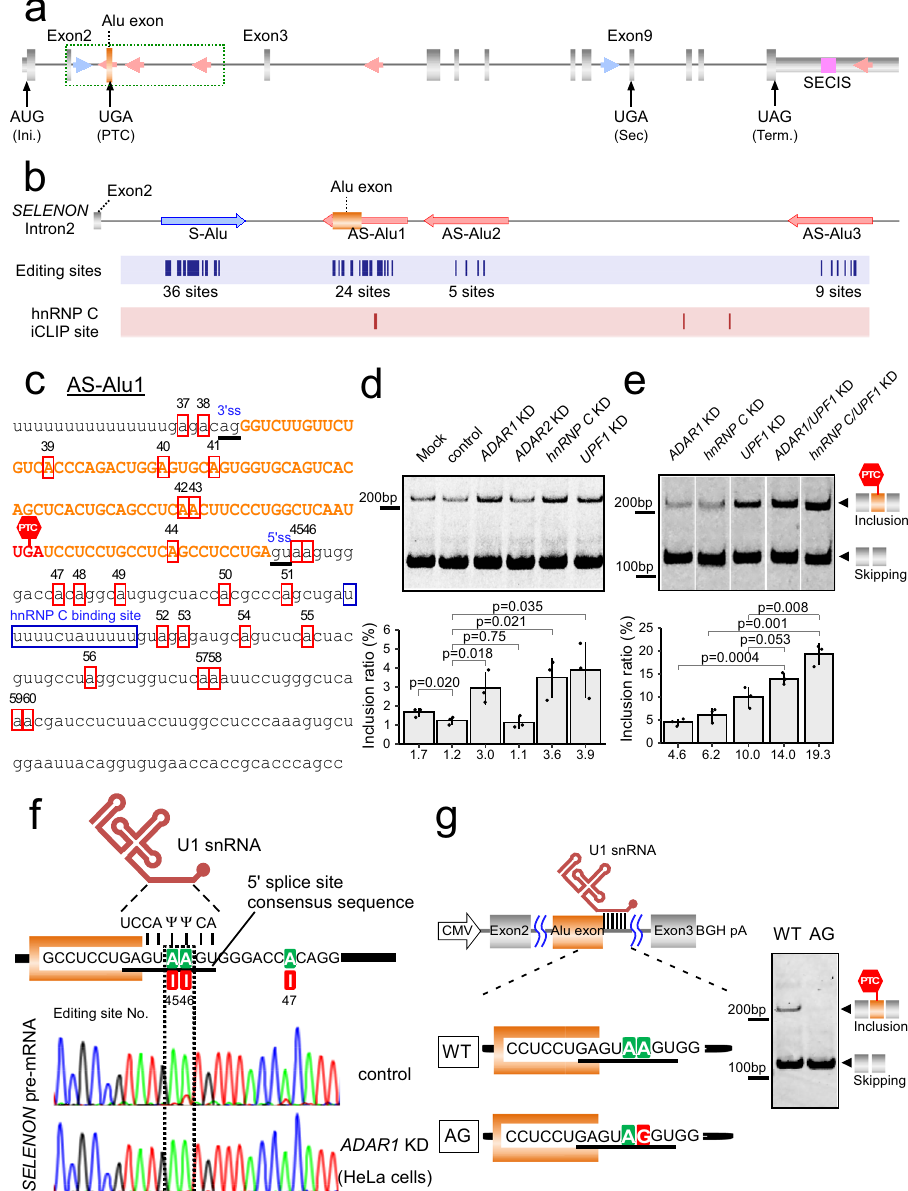
Fig. 1 ADAR1 and hnRNP C suppress Alu exonization of SELENON mRNA. a Human SELENON gene with exons (boxes) and introns (lines). The Alu exon and SECIS are indicated by orange and magenta boxes, respectively. Sense and antisense strands of Alu elements are indicated by blue and red arrows, respectively. Int. and Term. represent initiation and termination codons. b Intronic region of SELENON including four Alu elements (green dashed box in a ). Purple column represents A-to-I editing sites determined by ICE method. Pink column represents iCLIP sites for hnRNP C 49 . c RNA sequence of AS-Alu1 in SELENON . A-to-I editing sites are boxed in red, with site numbers shown in Supplementary Fig. 5. hnRNP C binding site identi fi ed by iCLIP is boxed. The Alu exon sequence is colored in orange. 3 ′ SS and 5 ′ SS of the Alu exon are indicated by underbars. PTC (UGA) is indicated in red. d Alu exonization of SELENON in HeLa cells upon knockdown of each target mRNA. Control siRNA targeted luciferase. Upper panel shows RT-PCR products of a part of SELENON mRNA spanning exons 2 and 3. Lower panel shows the inclusion ratio (%), determined by RT-qPCR. Data are presented as mean values ±S.D. Statistical signi fi cance was determined by an unpaired two-tailed t test; n = 3 biologically independent samples. e Alu exonization of SELENON in HeLa cells upon double-knockdown of target mRNAs. Upper panel shows the inclusion and skipping isoforms with a schematical illustration. Lower panel shows the inclusion ratio (%), as described in d , above. f cDNA sequences of the Alu exon 5 ′ SS in SELENON pre-mRNAs from HeLa cells treated with siRNAs targeting luciferase (control) and ADAR1 (KD). The editing sites are indicated. Consensus sequence of 5 ′ SS (underlined) base-pairs with a part of U1 snRNA. The electropherograms for A, G, T, and C are colored green, red, gray, and blue, respectively. Ψ , pseudouridine. g Minigene constructs bearing the Alu exon (WT) or its editing-mimic mutant (AG). Skipping and inclusion isoforms from the minigene were detected by RT-PCR. This experiment was done once. Source data and unprocessed gel images are provided in Source Data fi